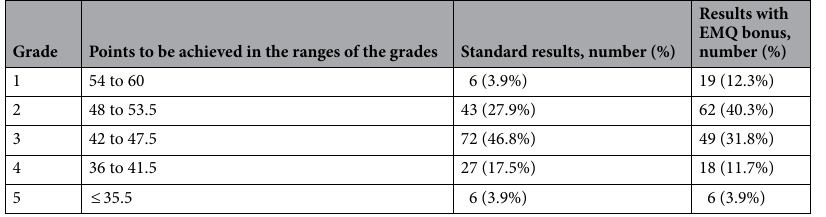
Table 1. Student performance in the examination, achievement as standard results and following the addition of EMQ bonus points.